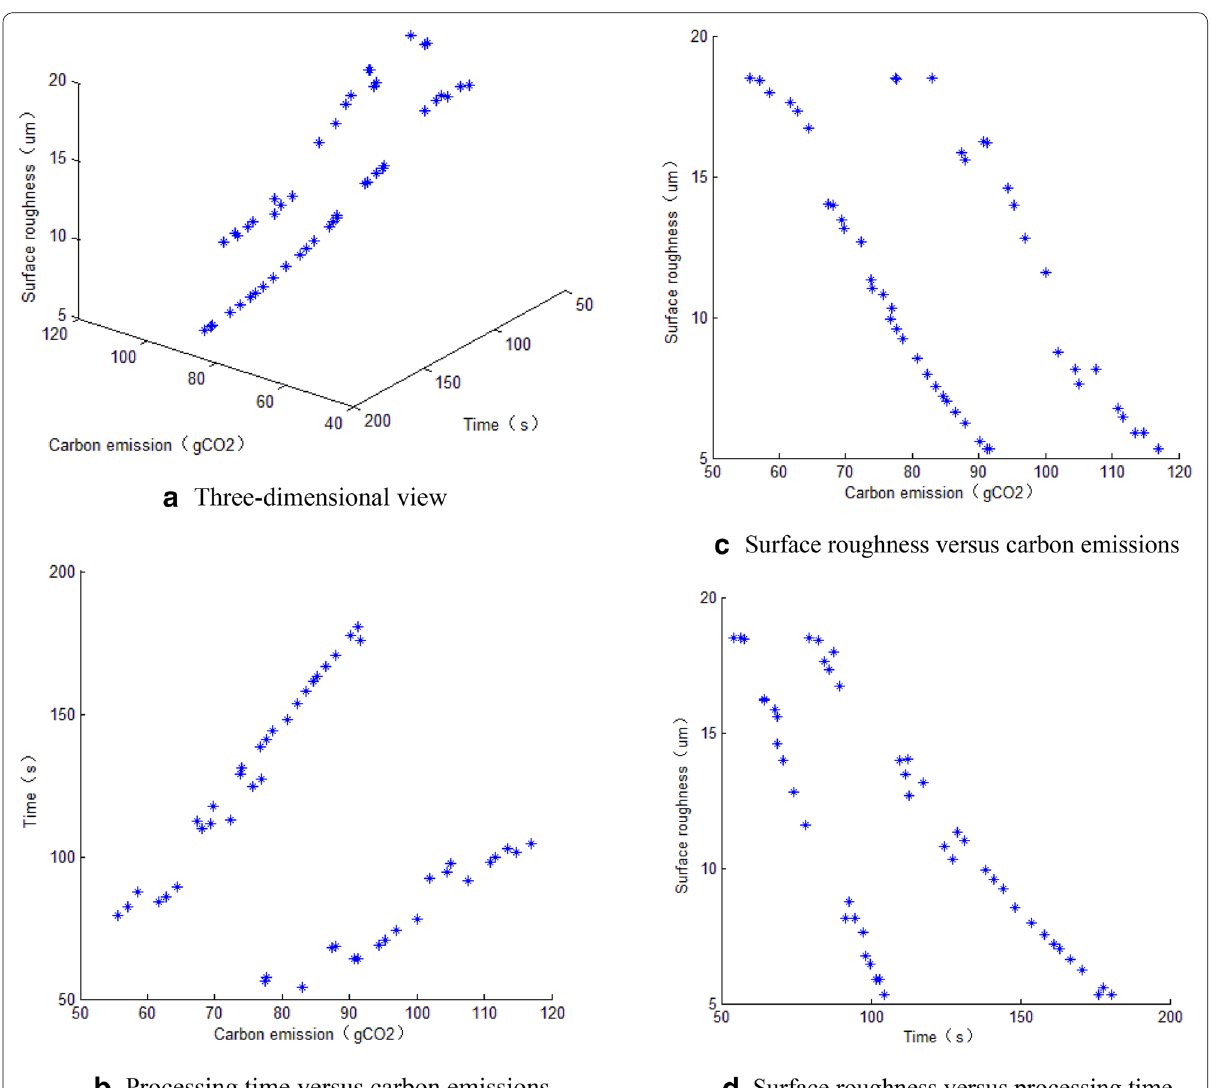
Figure 5 Pareto front of multi-objective